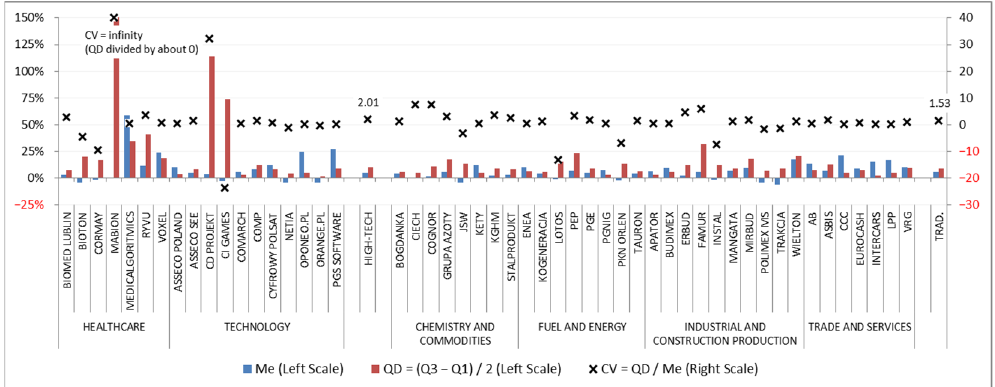
Figure 4. Assessment of changes in sales revenues in the surveyed enterprises. Source: own work.